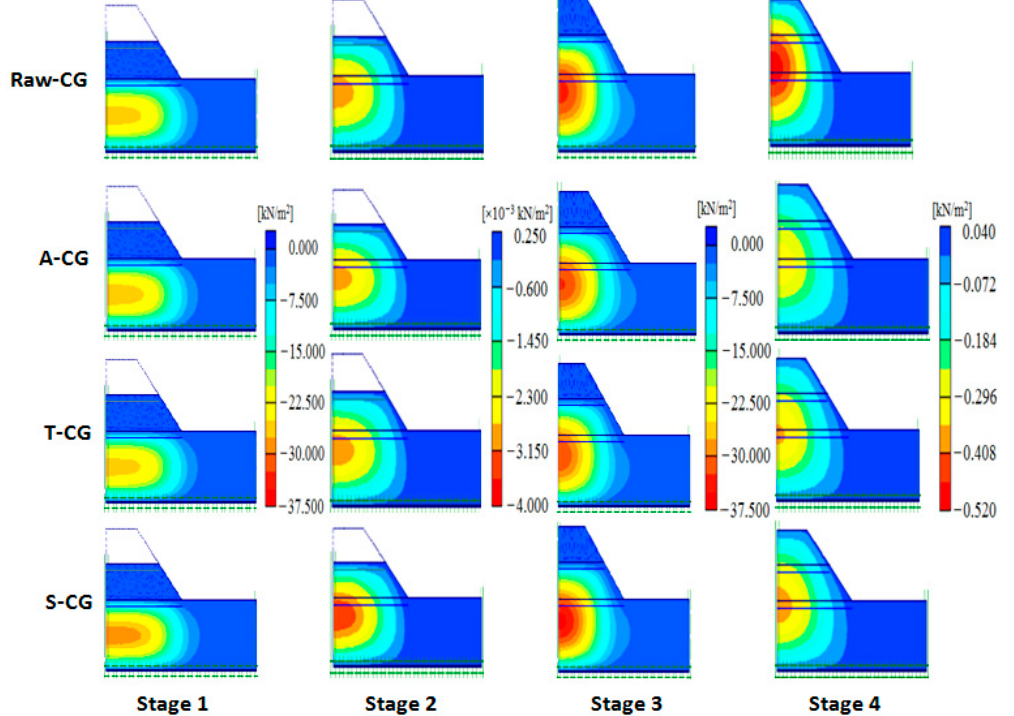
Figure 4. Pore water pressure cloud model. Table 6. Maximum excess pore water pressure /kN m − 2 .